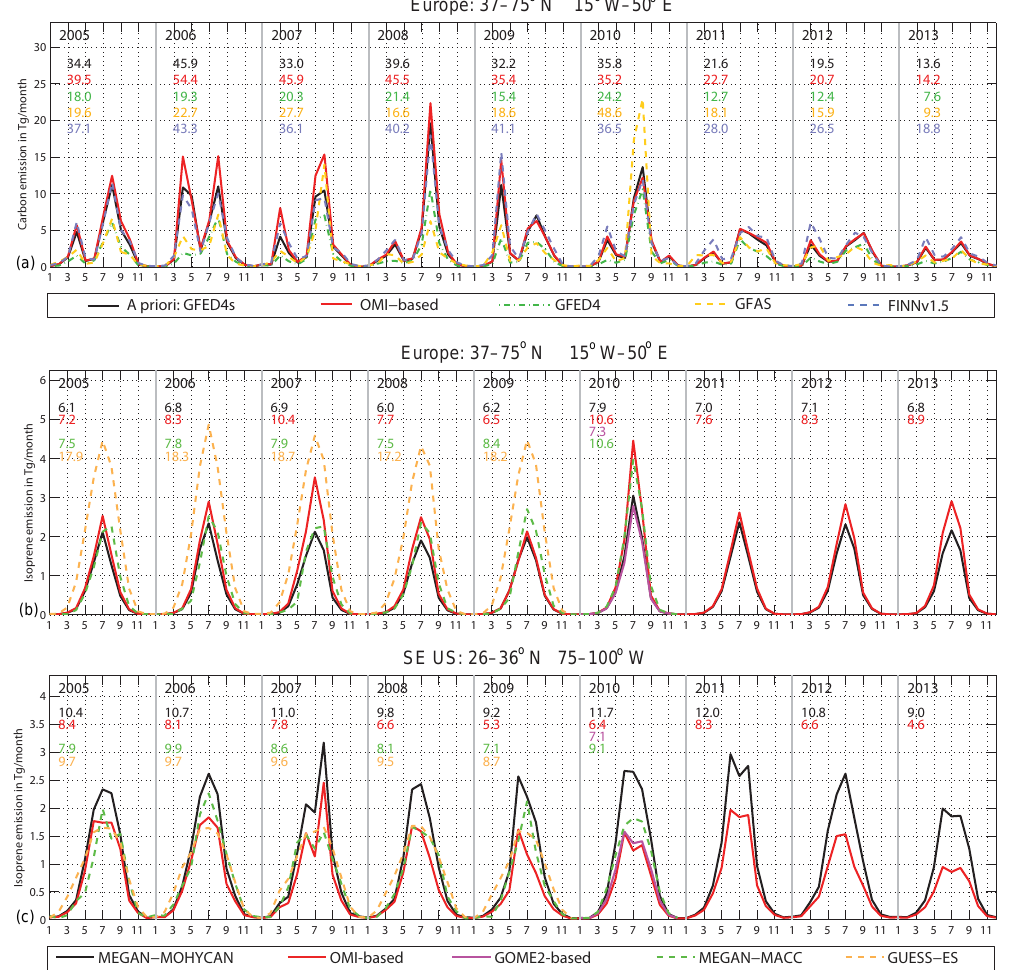
Figure 15. As Fig. 9 but for Europe and the southeast